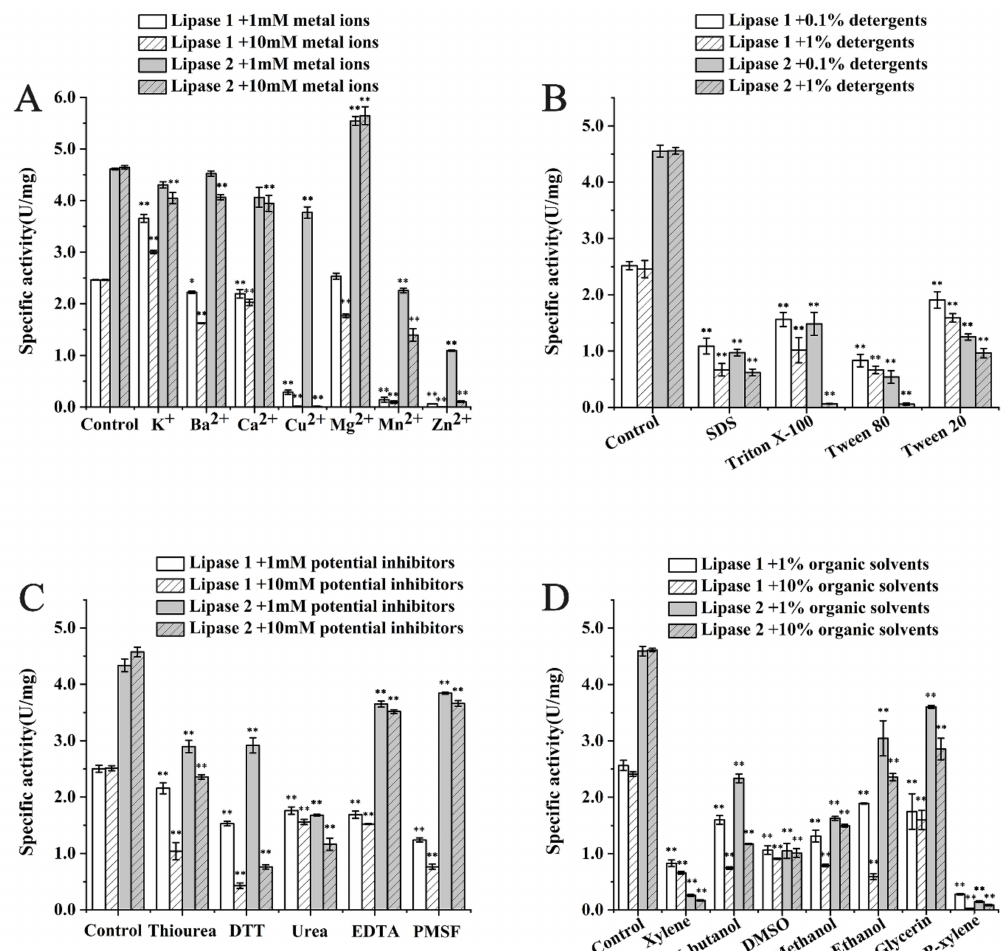
Figure 4. Stability of Lipase 1 and Lipase 2 against different metal ions ( A ), detergents ( B ), potential inhibitors ( C ), and organic solvents ( D ). All the data are represented by the mean ± standard deviation (SD). * p < 0.05, ** p < 0.01 vs. Control (The enzyme solution without any treatment).